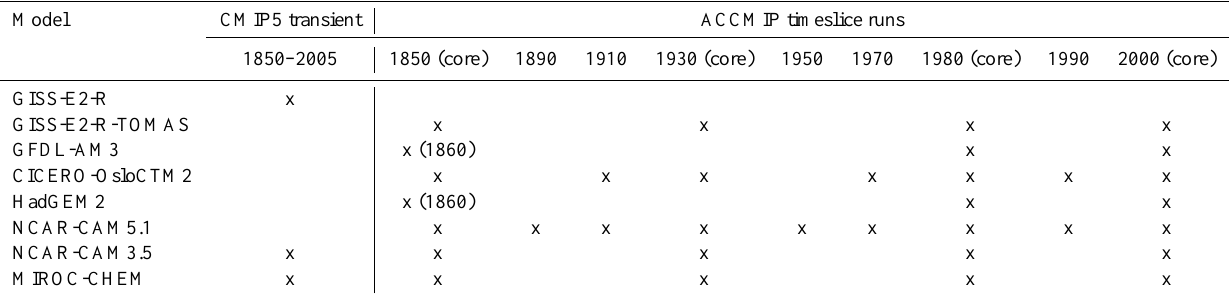
Table 1. Model BC output availability in CMIP5 transient and ACCMIP timeslice historical runs used in this study. The core ACCMIP timeslice runs are shown with (core). “x” means no model output is available for the corresponding year. GFDL-AM3 and HadGEM2 ran 1860 timeslice instead of